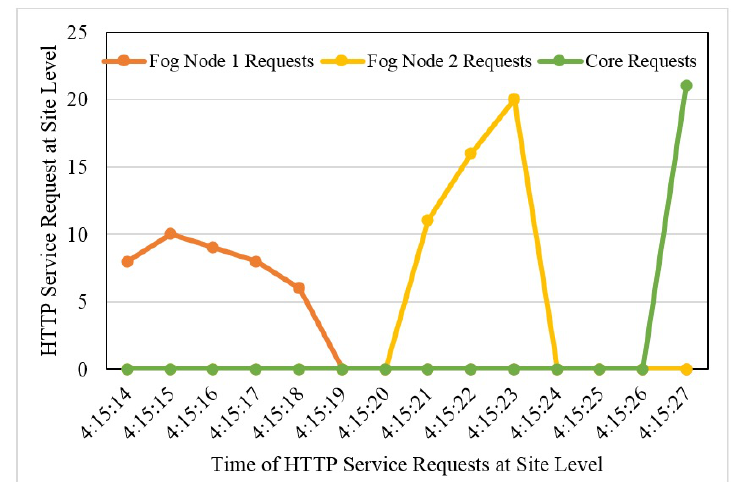
Figure 10. Request direction at serving nodes.